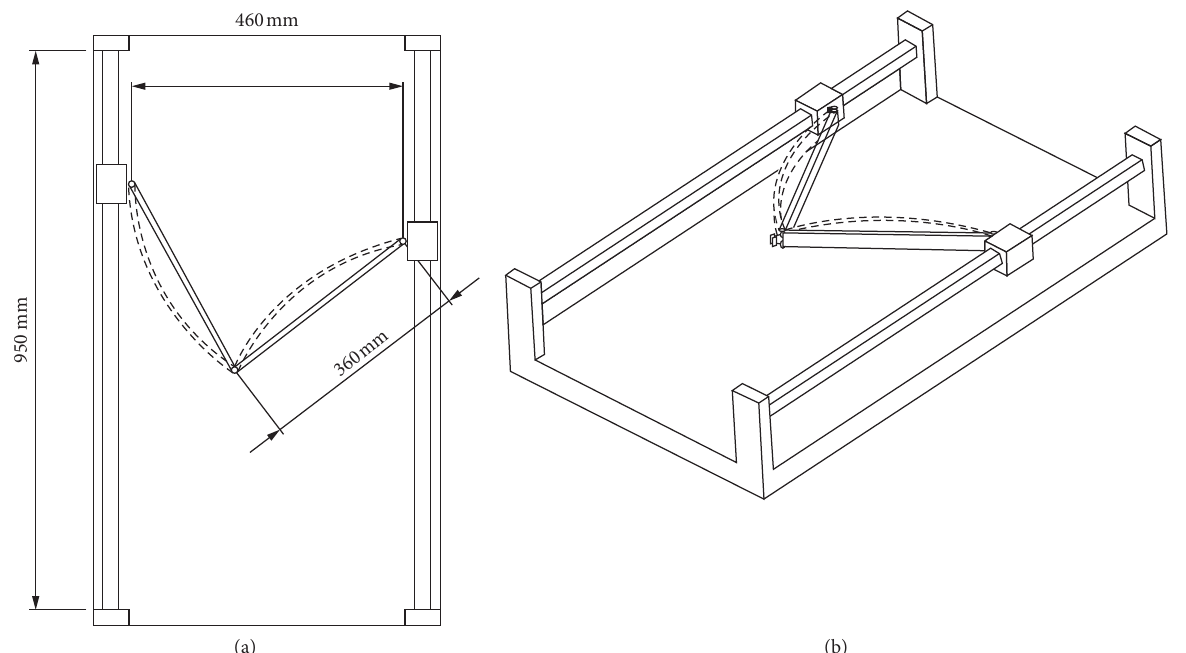
Figure 1: Architecture of 2-PRRRP with flexible links (dashed lines denote the deflection of the links).